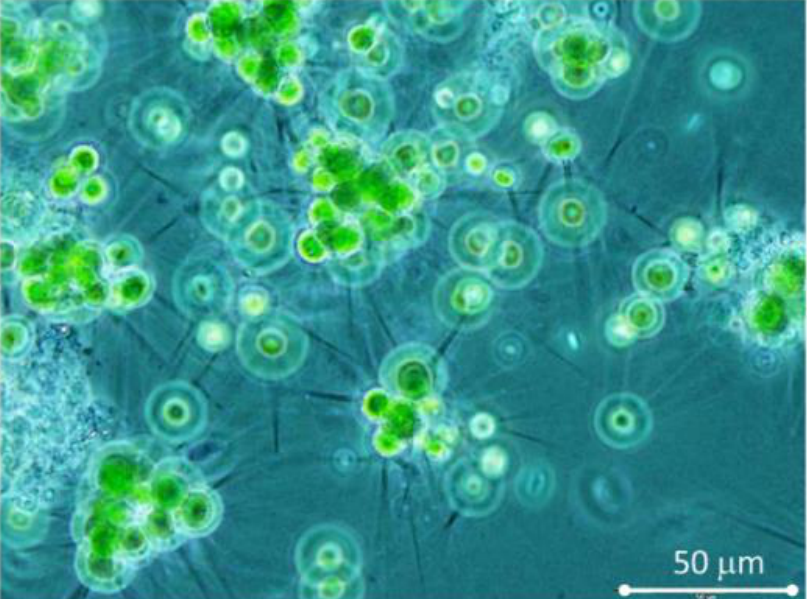
Figure 2. Spherical single cells or colonies of the green microalgae Micractinium pusillum with and without long spines (cell of about diameter 8 µ m, biovolume 265 µ m 3 ) were the major species in the water bloom grown in bioreactors. The image was taken at 400 × magnification using phase contrast illumination.